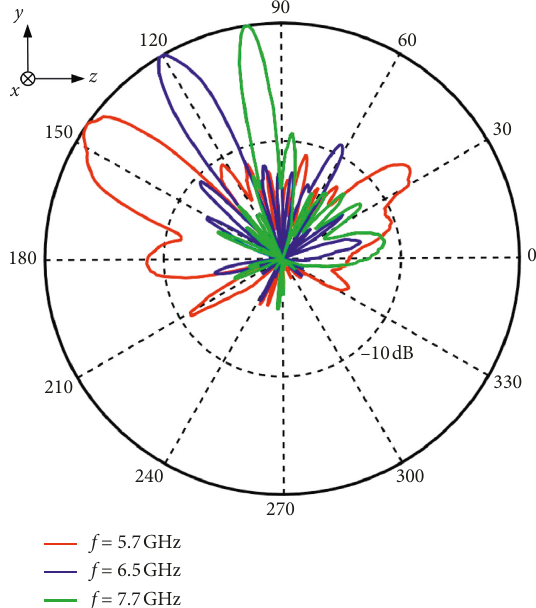
Figure 9: The measured radiation pattern of the proposed periodic antenna in the forward direction.